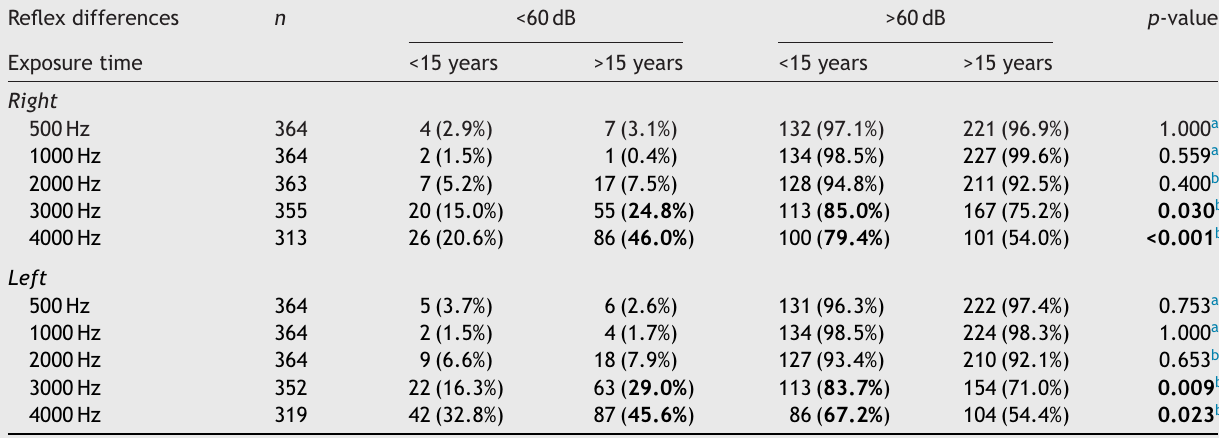
Table 12 Comparison of noise exposure time of workers and occurrence of Metz recruitment. Reflex differences n <60 dB >60 dB p -value Exposure time <15 years Right